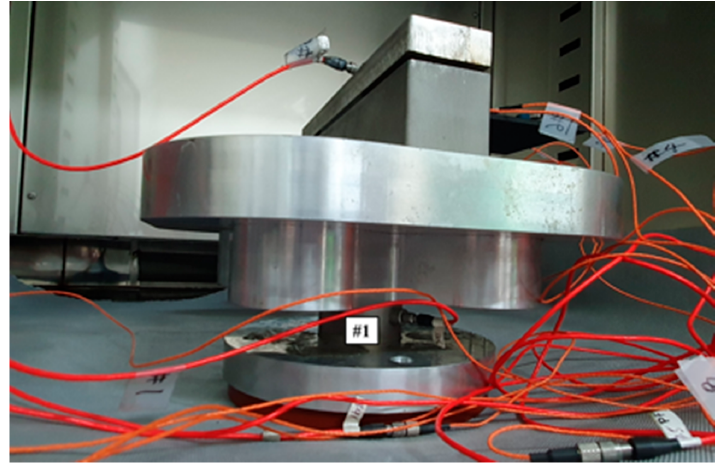
Figure 3. Location of the force sensor: the force sensor was attached beneath the clamping jig.